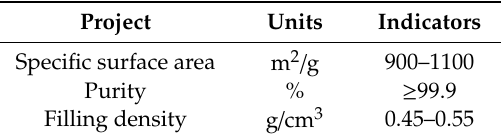
Table 2. Basic properties of active carbon.